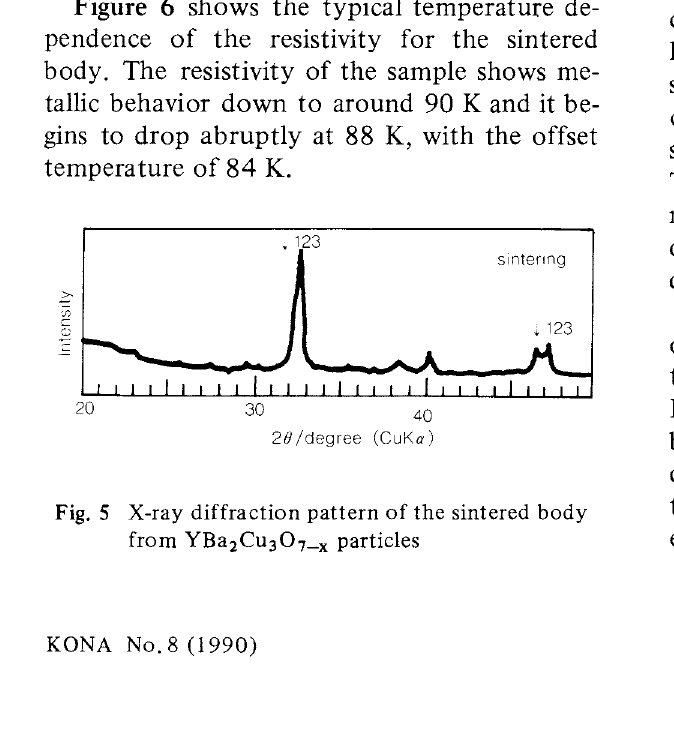
Fig. 5 X-ray diffraction pattern of the sintered body from YBa2Cu307-x particles